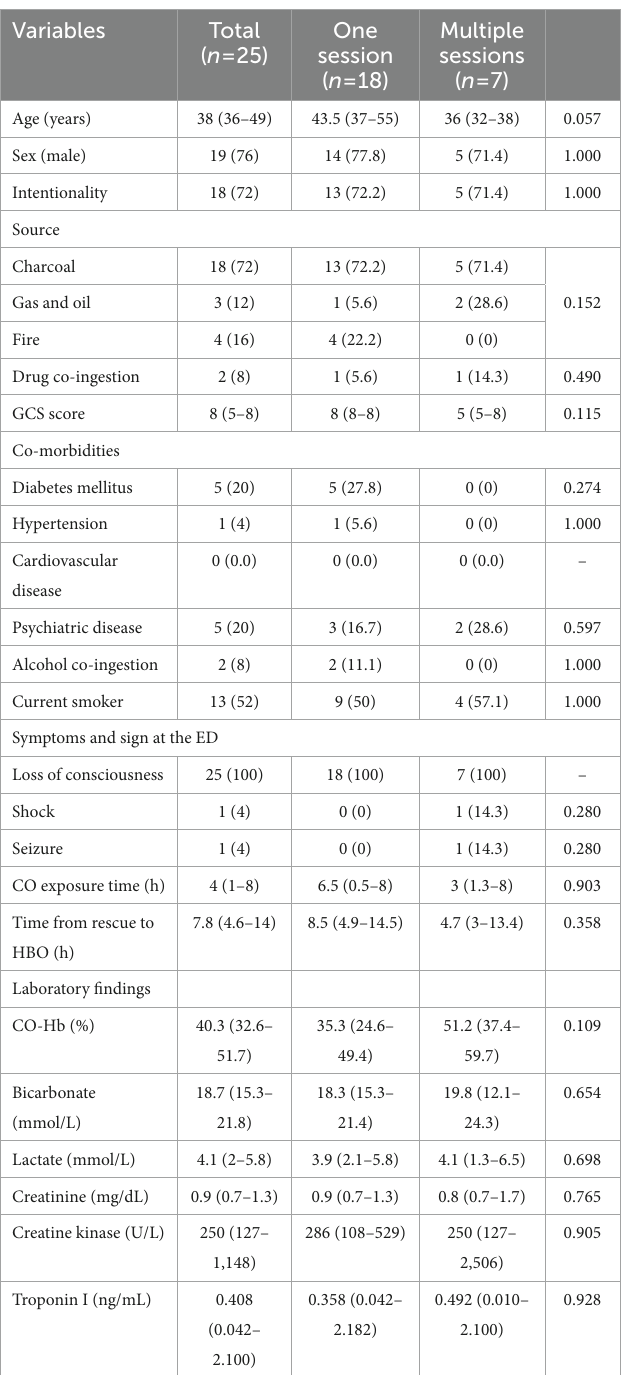
TABLE 3 Baseline characteristics in the non-invasive mechanical ventilation